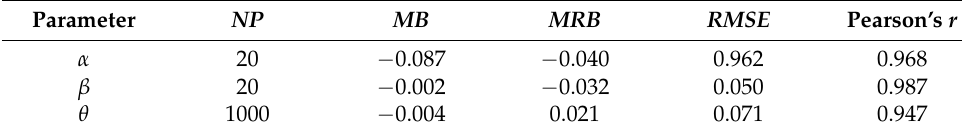
Table 3. Statistics for the Parameter Replicability Analysis.